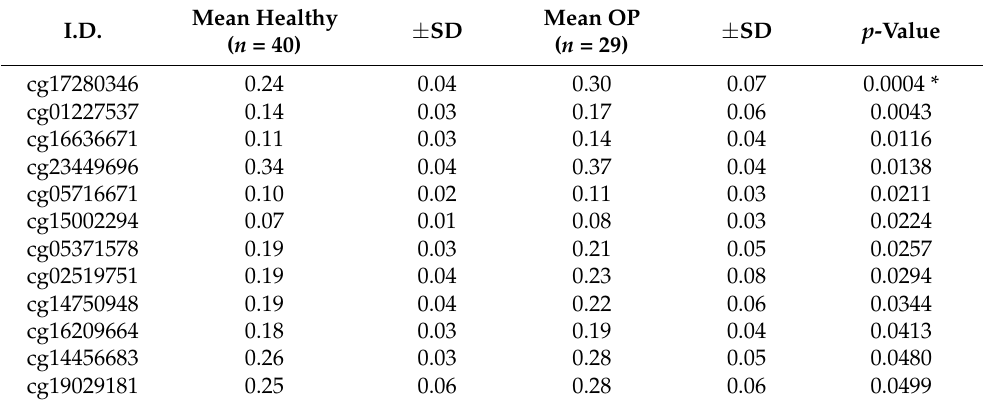
Table 3. Differential ZIC1 DNA methylation levels observed between osteoporotic (OP) and healthy subjects at iliac bone